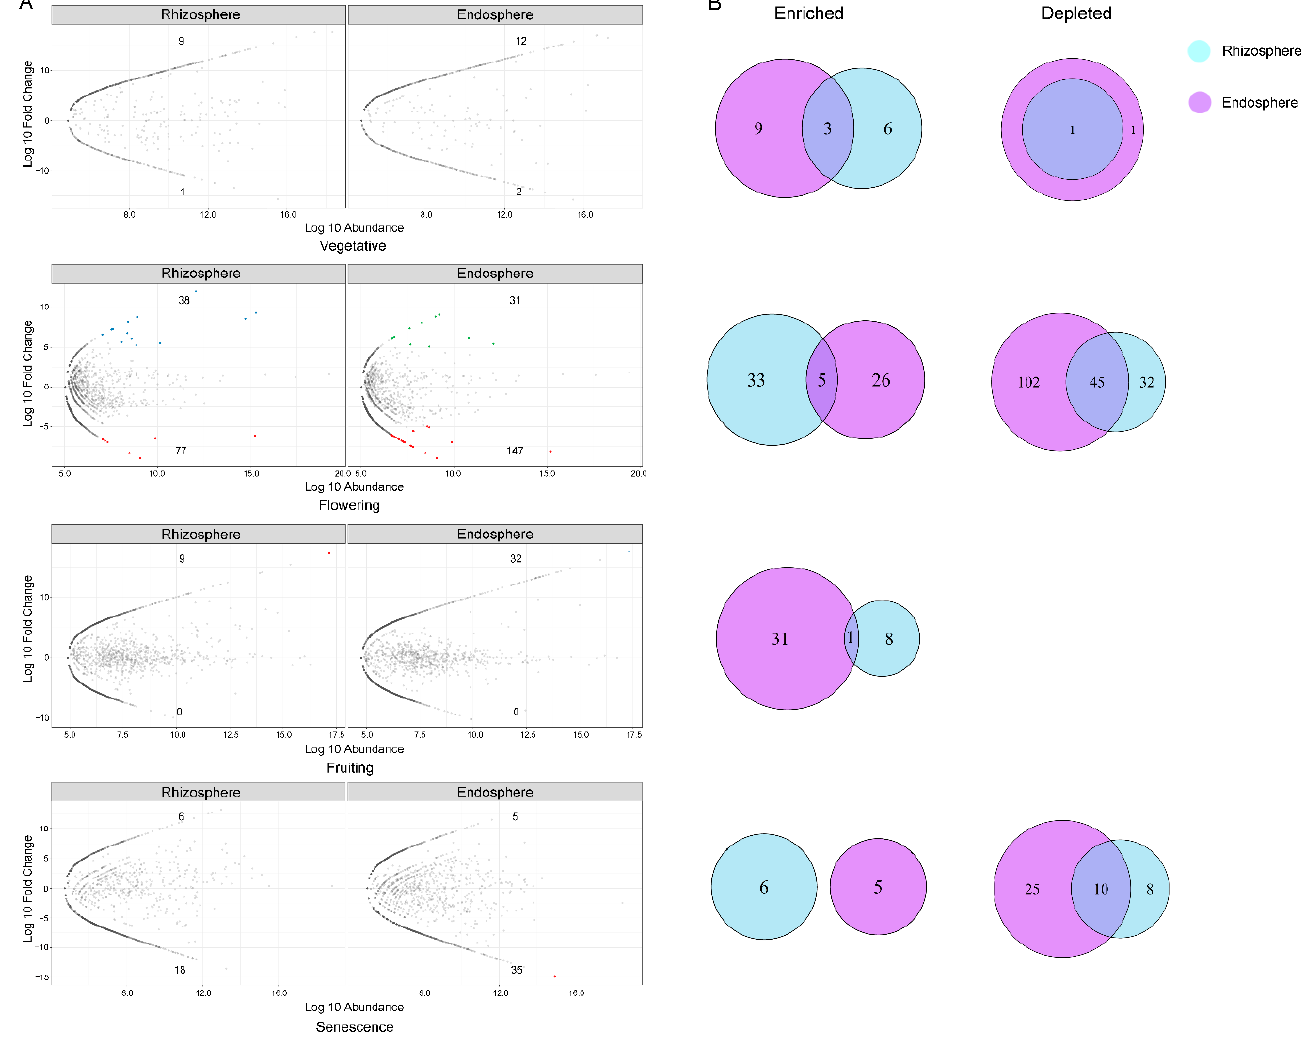
Figure 6. Comparison between two rhizocompartments in each growth stage of fungal communities. ( A ) Enrichment and depletion of 18S OTUs for each rhizocompartment (rhizosphere and endosphere) compared with the bulk soil in four growth stage as determined by differential abundance analysis. Each point represents an individual OTU, of which the blue and purple points represent enriched OTUs in each compartment compared to the bulk soil, while the red ones indicate depleted OTUs, and the grey points represent no difference in abundance between each root compartment and bulk soil. The position along the y-axis represents the abundance fold change compared with bulk soil. ( B ) Venn diagrams showing the numbers of differentially enriched and depleted OTUs between each compartment compared with the bulk soil.